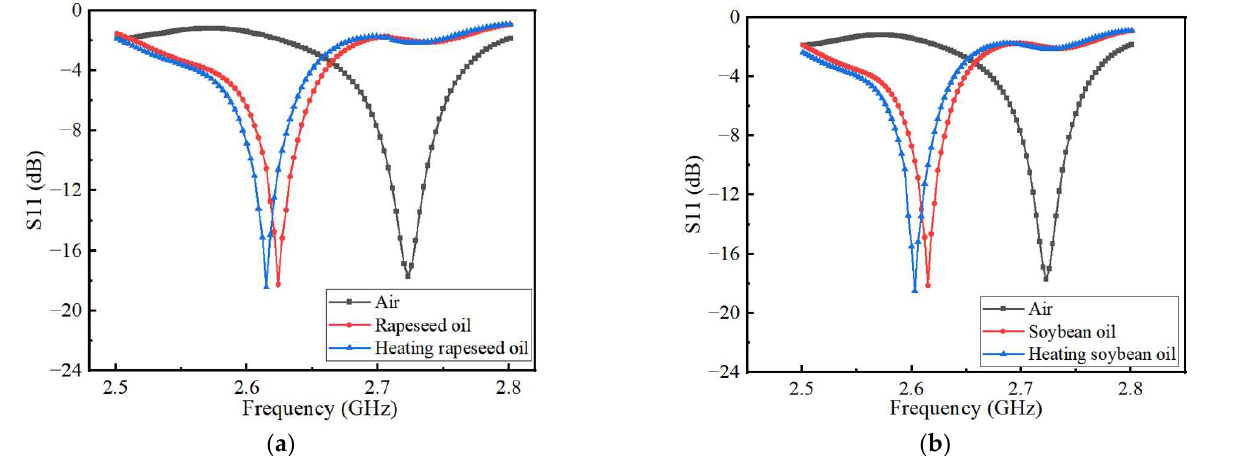
Figure 13. Measurement results of the effect of different edible oil on the resonant frequency of the sensor before and after heating ( a ) canola oil and ( b ) soybean oil.